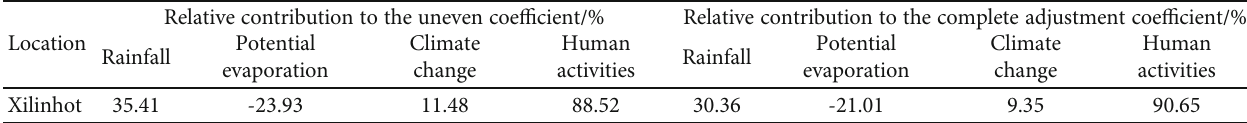
Table 4: Relative contribution of climate change and human activities to the change in characteristic values of runo ff seasonal distribution in Xilinhe